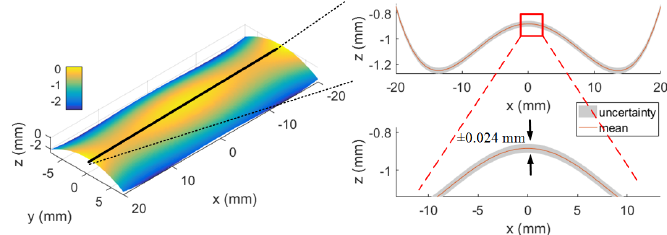
Figure 12. Fused result with the maximum likelihood data fusion method.